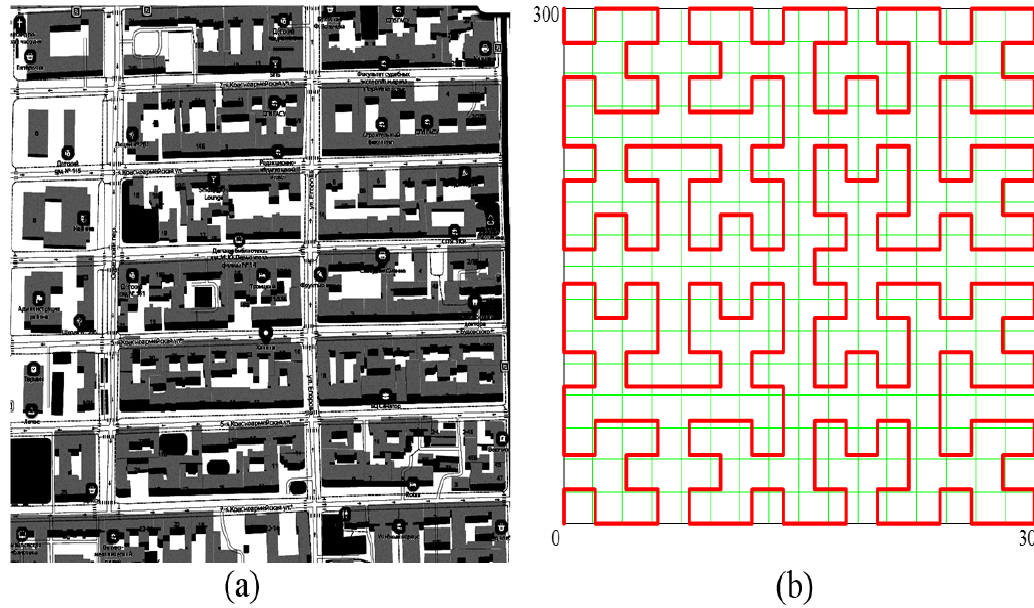
Figure 4. Fragment of the city plan ( a ) and a fragment of the Hilbert curve ( b